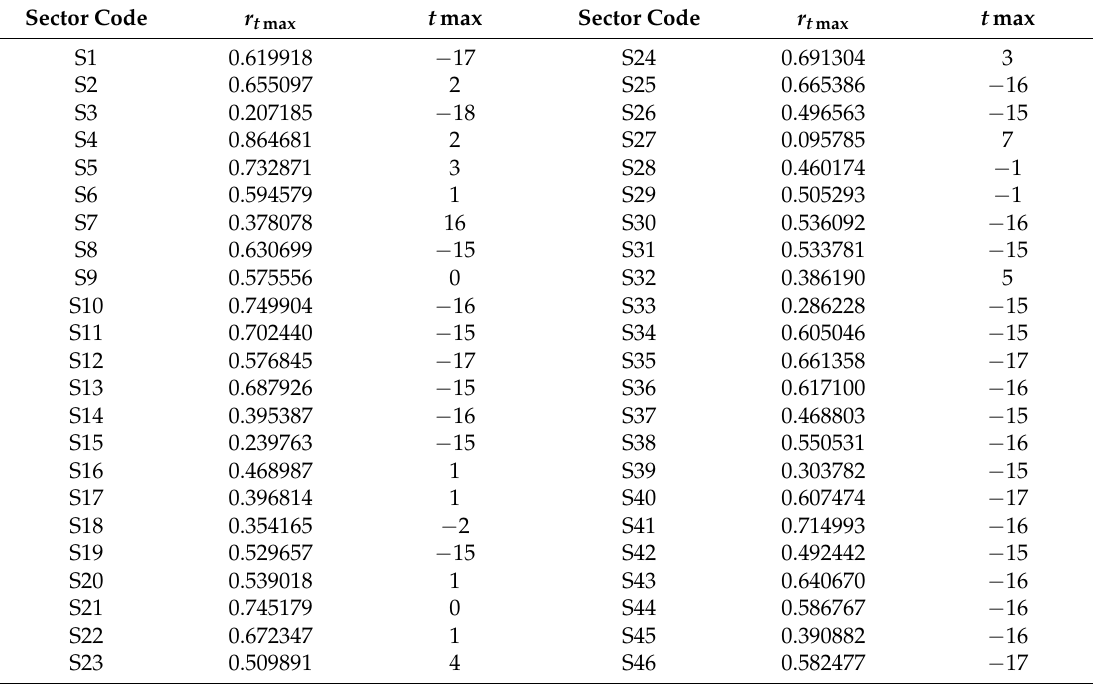
Table 1. The maximum value of correlation coefficient and corresponding